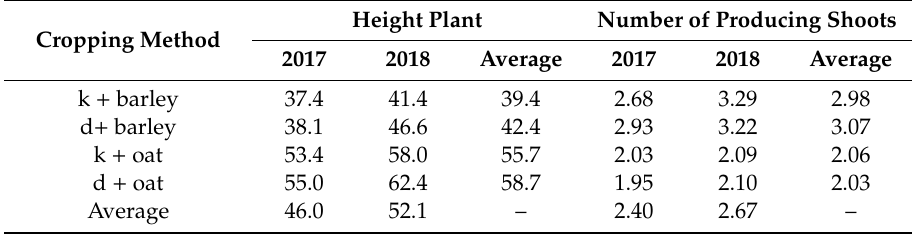
Table 10. Height plant (cm) and number of producing shoots of cereals depending on type (k—kabuli;